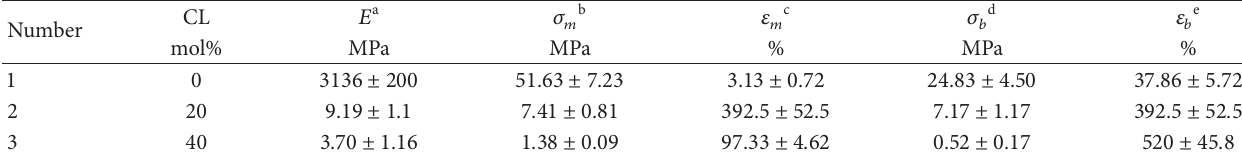
Table 2: Mechanical properties of the PLGC copolymers.